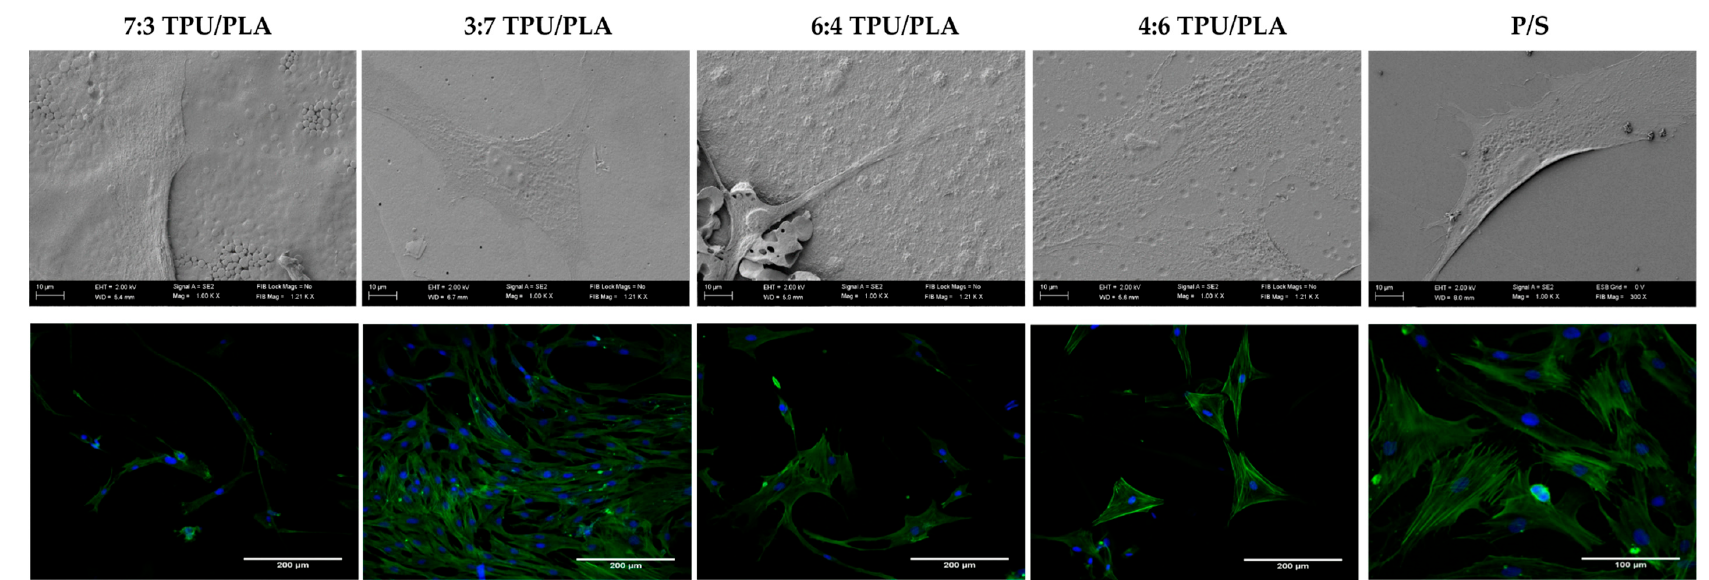
Figure 2. The morphology of hASCs cultured onto obtained (TPU+PLA) blends. The morphology of cells was visualized using scanning electron microscope (SEM) and confocal microscope. The SEM images (revealed the adhesion rate of hASCs on tested (TPU+PLA) blends, and some biomimetic features of films). For confocal observations, cells were stained with DAPI, to localize the nuclei (blue dots) and with phalloidin atto-488 (green, actin cytoskeleton). SEM microphotographs were captured under 1000× magnification (scale bar is 10 μ m), while confocal observations were performed at magnification 40× (scale bar 200 μ m).